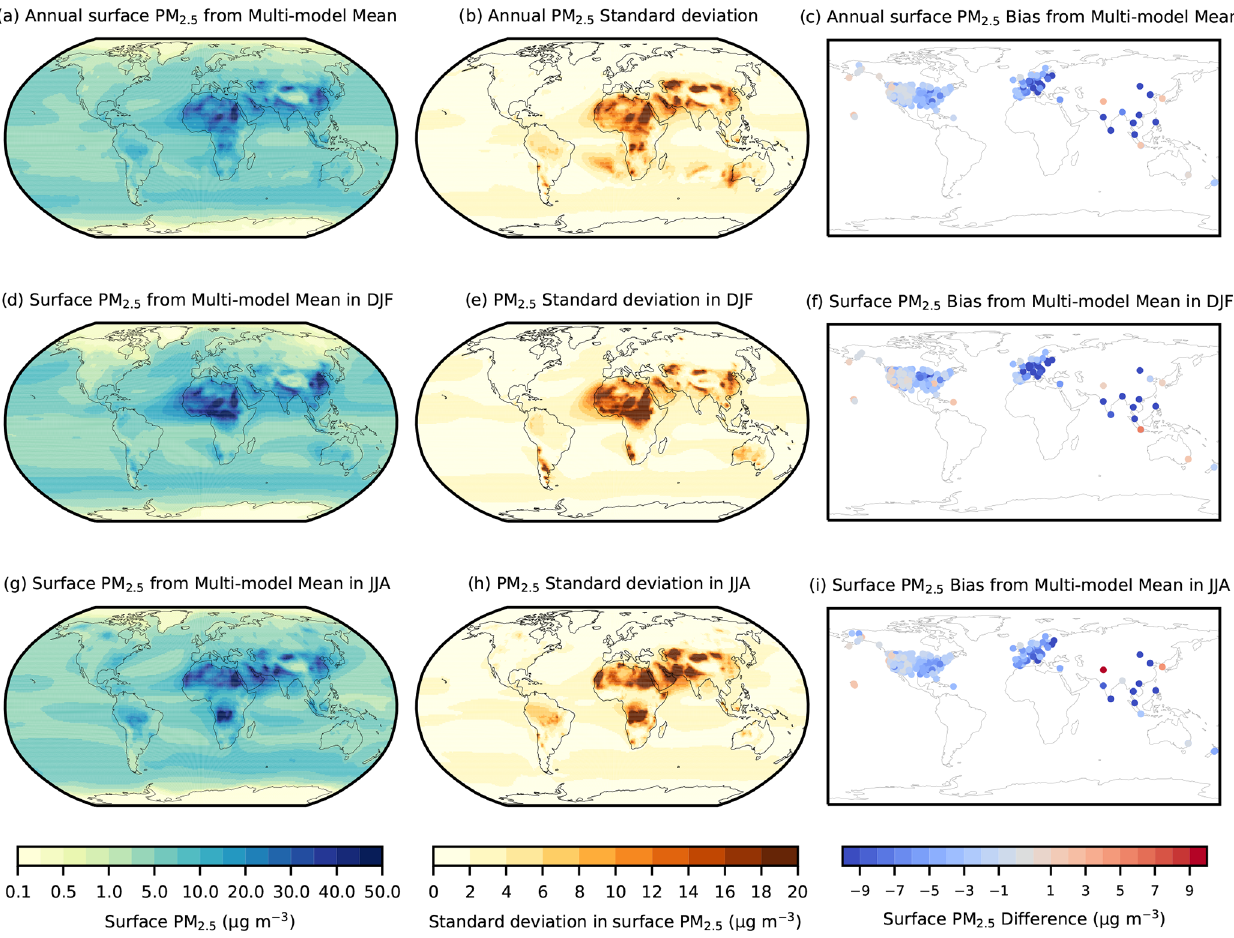
Figure 5. Multi-model (11 CMIP6 models) annual and seasonal mean surface PM 2 . 5 concentrations over the 2000–2010 period in (a) annual mean; (d) December, January and February (DJF); and (g) June, July and August (JJA). The SD of the multi-model mean in (b) annual mean, (e) DJF and (h) JJA. The difference between the multi-model mean and PM 2 . 5 observations in (c) annual mean, (f) DJF and (i) JJA (colour bar